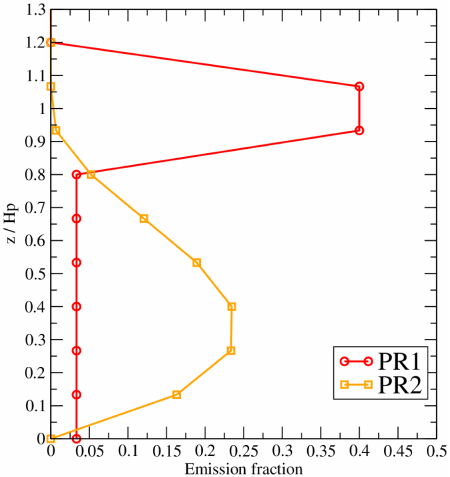
Figure 2. Vertical profiles of factors used for the injection of biomass burning emissions in the